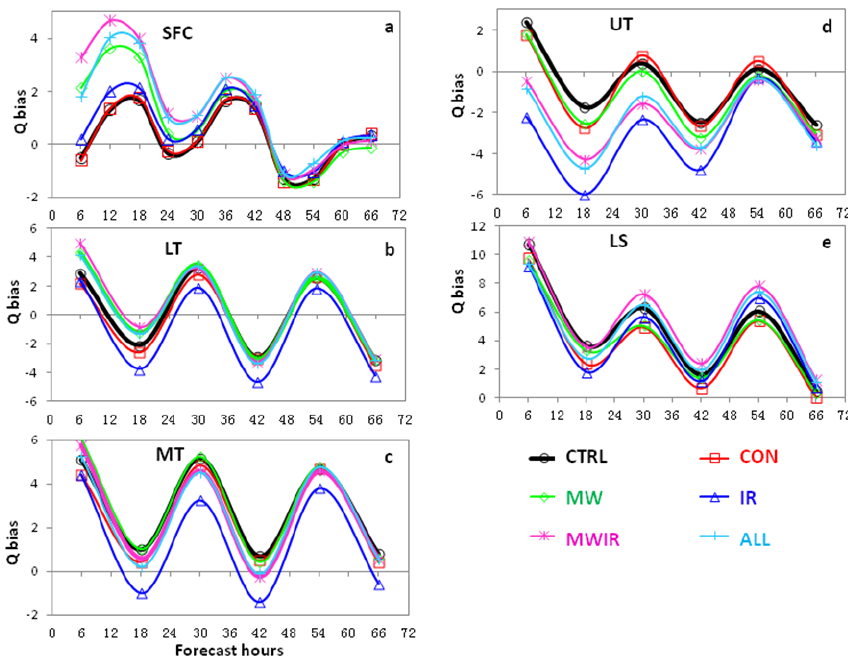
Figure 8. The bias of the specific humidity ( Q ) forecasts at (a) surface (SFC), (b) lower troposphere (LT), (c) middle troposphere (MT),